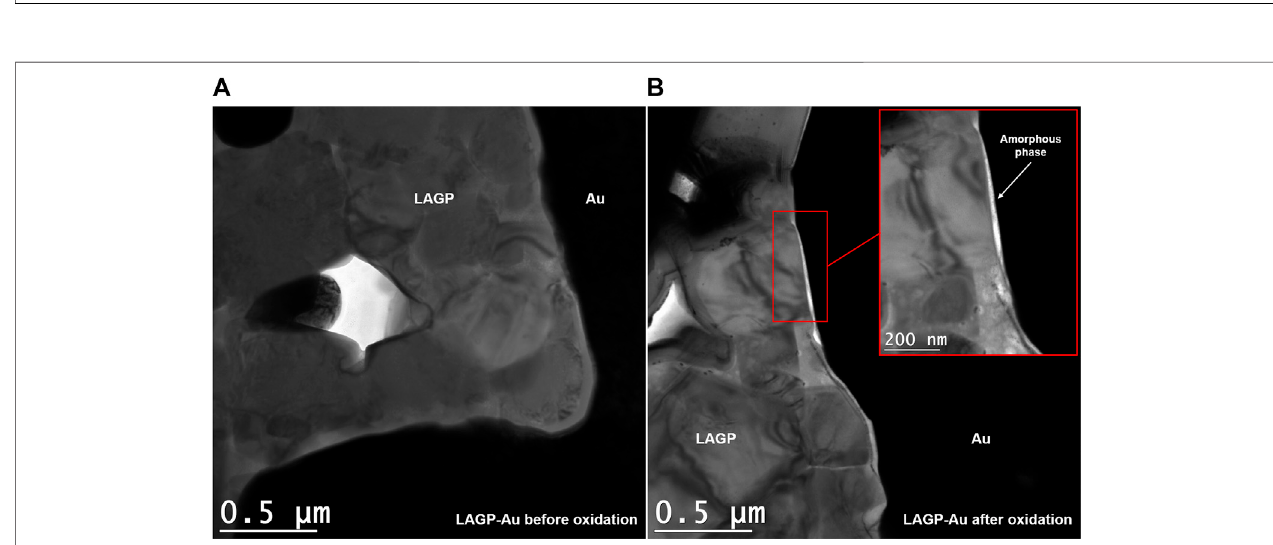
FIGURE 7 | Bright- fi eld TEM micrographs ( × 10k) of two LAGP-Au composite samples (A) before and (B) after oxidation. The inset was observed at × 25k.